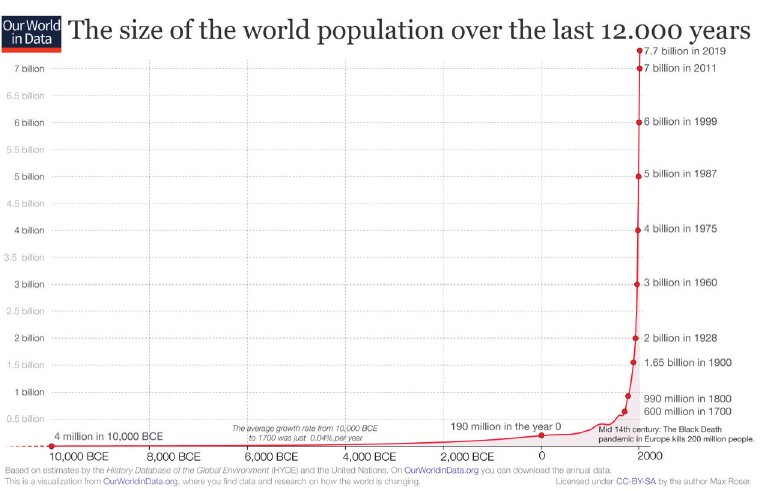
Figure 3: Population growth over the last 12,000 years